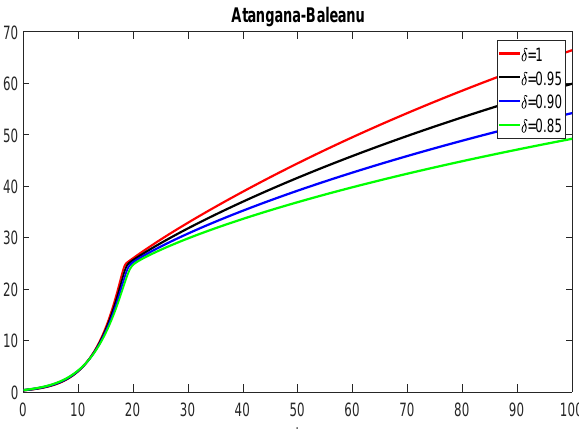
Figure 5. Evolution of the substrate, biomass, and ethanol for fractal dimension 0.8 and different fractional orders in Atangana–Baleanu sense.